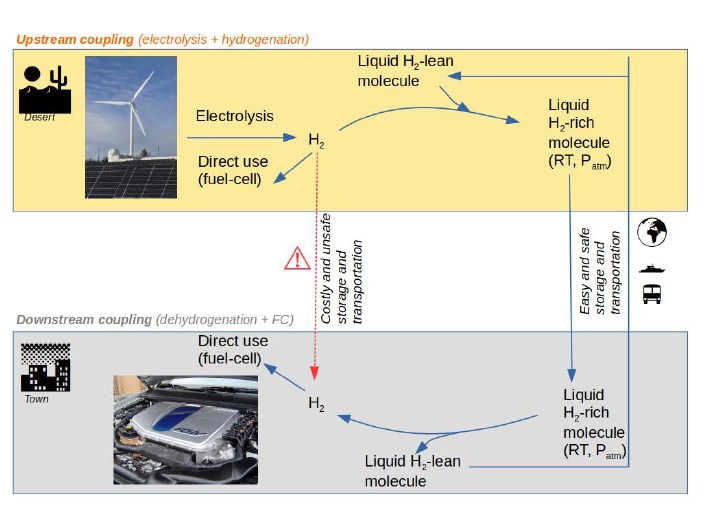
Figure 1. General picture illustrating the hydrogen storage in liquid organic